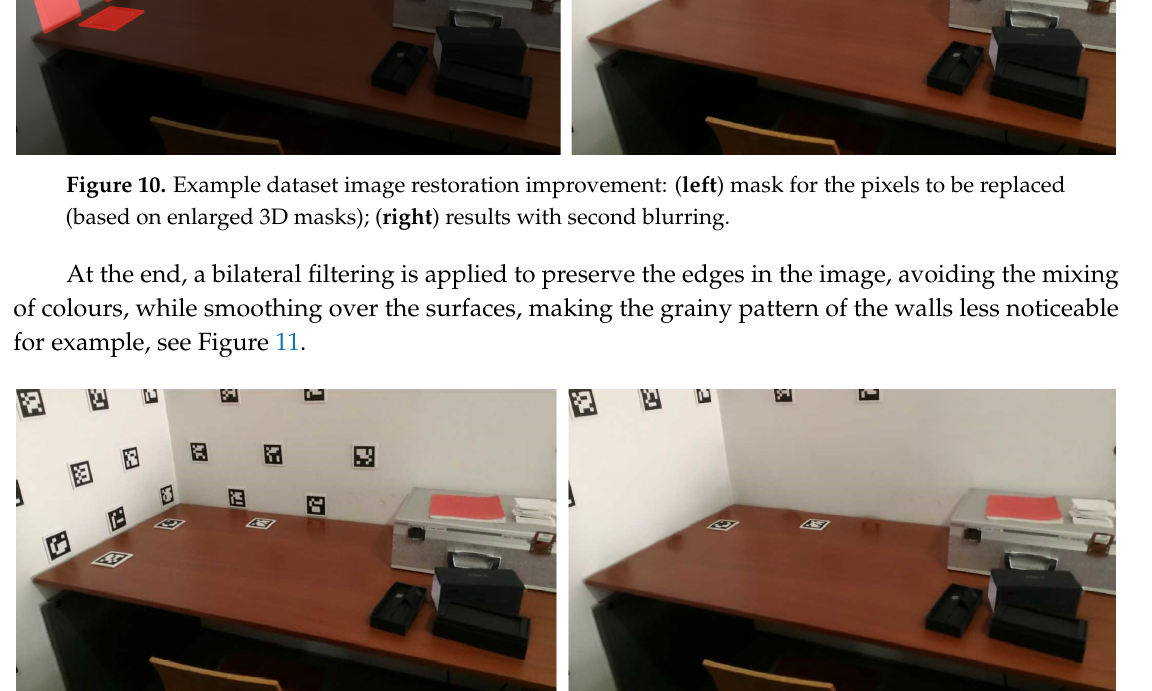
Figure 11. Example dataset image restoration: ( left ) original image; ( right ) restored